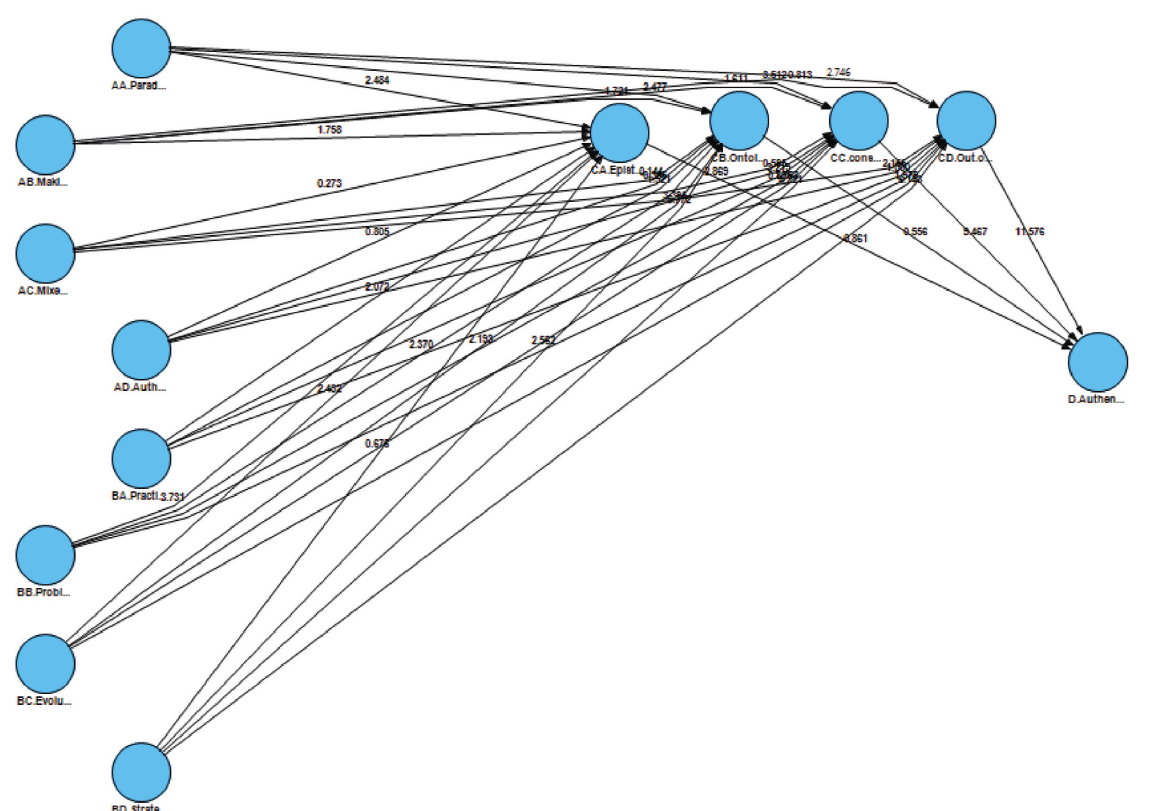
Figure 9: The internal model of second-order hypotheses in the general significance